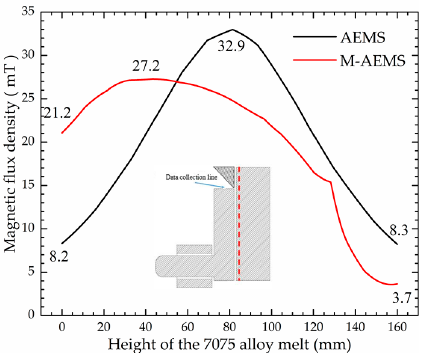
Figure 7. Comparison between the magnetic flux densities along a dashed line near the wall of the stirring crucible in the cases of AEMS and M-AEMS.